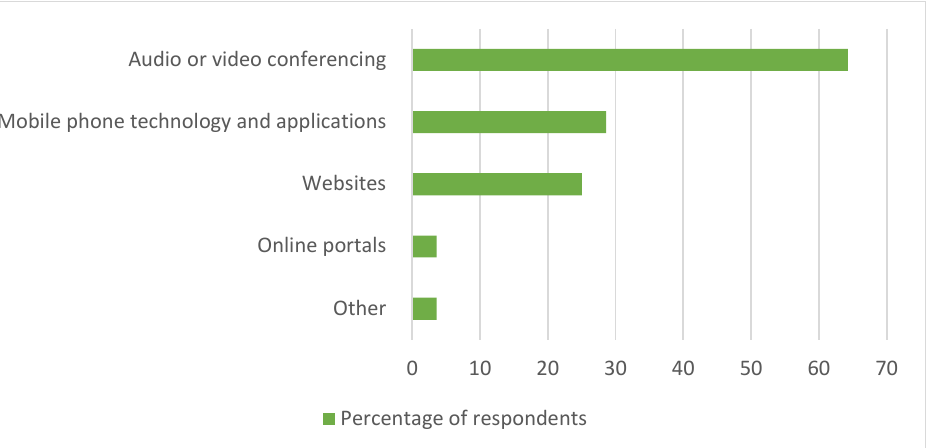
Figure 2. Types of telehealth services used in audiology departments within South African public sector hospitals as perceived by audiologists, indicated in terms of % ( n = 28). Table 1. Audiologists’ perceptions of telehealth practices within their hospital setting ( n =